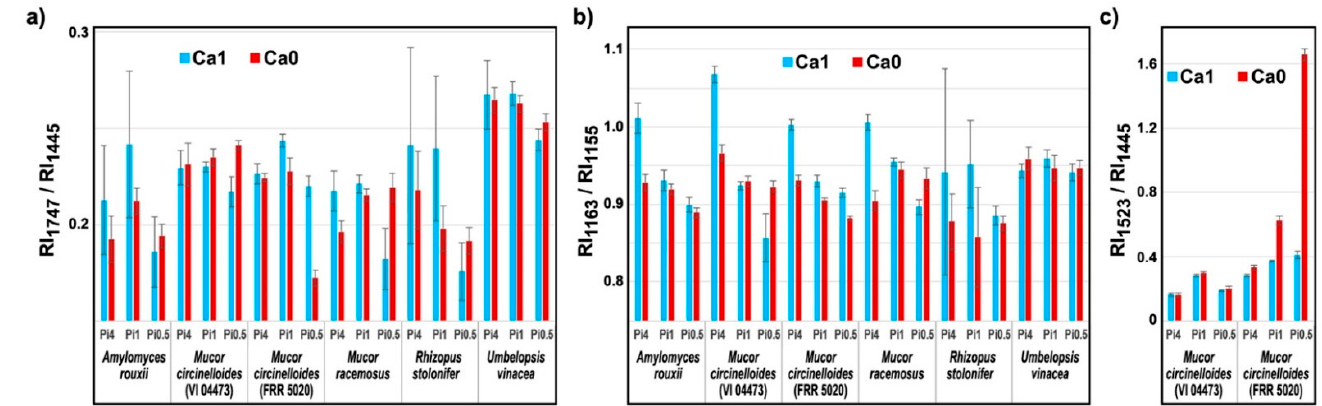
Figure 8. Ratio of Raman intensities at different wavenumbers related to chemical constituents of fungal biomass cultivated in six different growth conditions (phosphates concentrations and calcium availability). Ratio of Raman intensities at: ( a ) 1747 and 1445 cm − 1 related to lipids, ( b ) 1163 and 1155 cm − 1 related to polyphosphates, and ( c ) 1523 and 1445 cm − 1 related to carotenoids (average values and error is based on measurements of two biological replicates and three technical replicates). Analysis was based on nonderivative FT-Raman data.